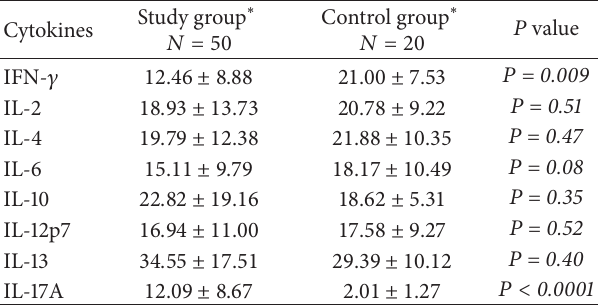
Table 2: Cytokine expression in study group with SPT positive for one or more food allergen and control